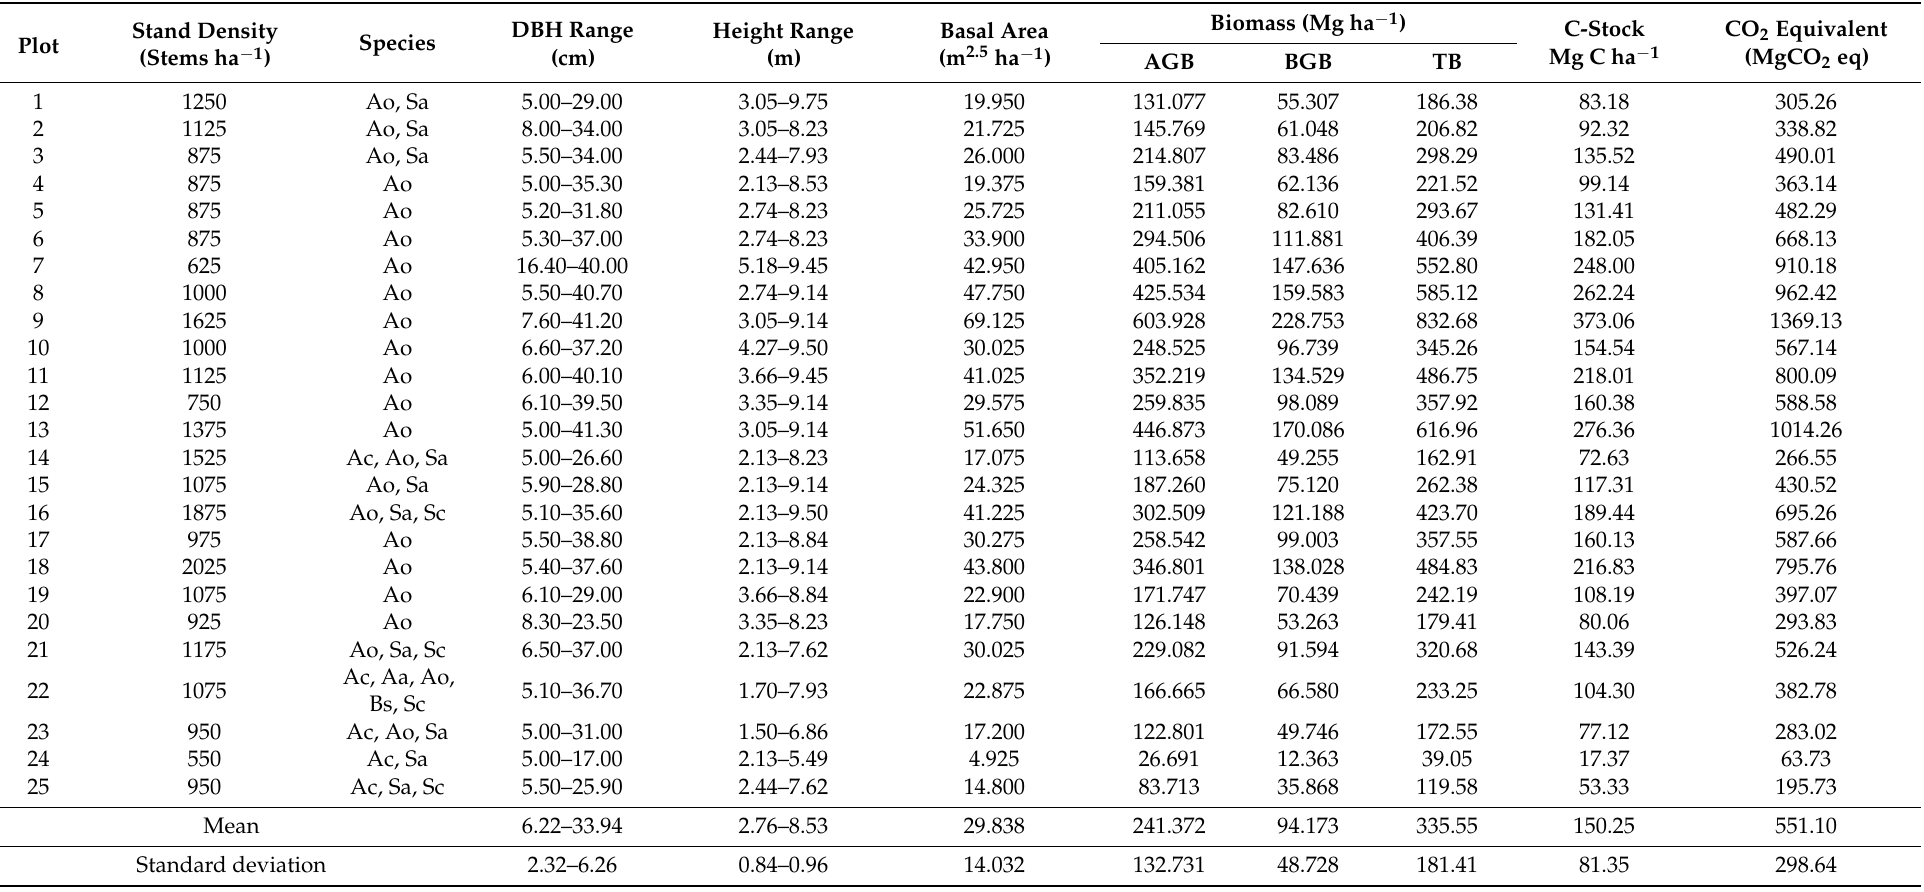
Table 1. Distribution of stand density, biomass, carbon stock, and CO 2 equivalent in the natural mangrove stand, LetKhutKon Village. Stand Plot